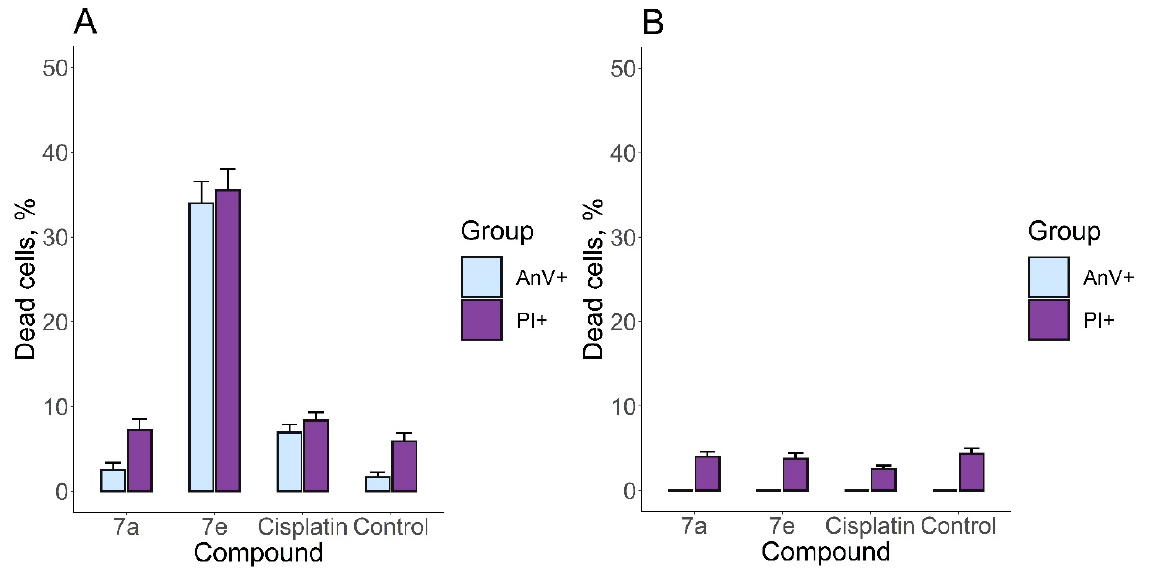
Figure 3. Comparison of the proportion of apoptotic (Annexin V+/PI-) and other dead cells (PI+) in glioblastoma A-172 ( A ) and human embryonic kidney HEK-293 ( B ) cultures, mean ± CI-95%. The data obtained confirm the marked effect of 7e against malignant cells (Figure 4), using the A-172 line as an example. In addition, the effect of the studied compounds was compared in the experiment with the widely used anticancer drug cisplatin at a similar concentration (6 µ M) to compare the intensity of the cytotoxic effect. Compound 7e showed a more intense effect against tumor cells of the A-172 line than cisplatin. At the same time, there was no significant increase in the number of dead cells in the HEK-293 line (Figures 3 and